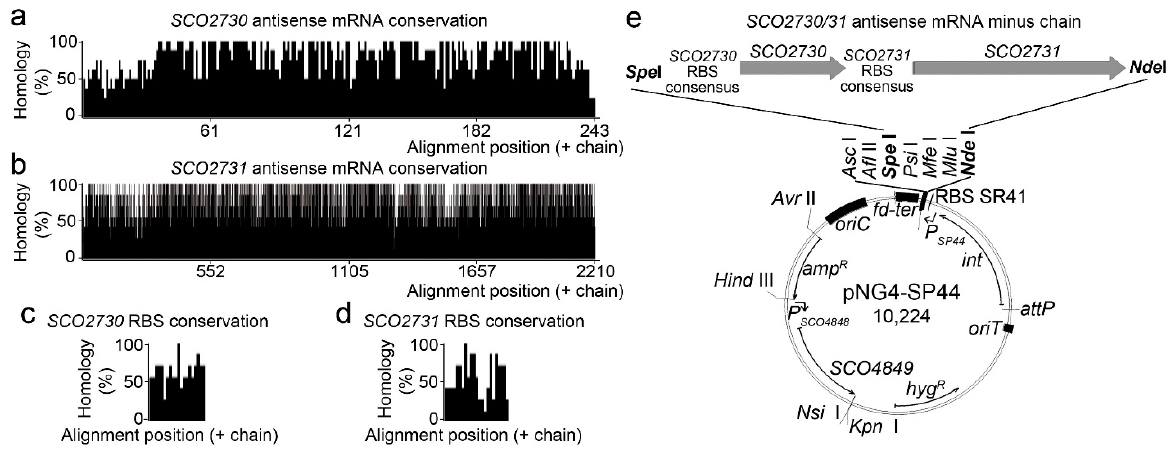
Figure 1. SCO2730/31 consensus antisense mRNA conservation and overexpression. ( a – d ) Histogram showing the percentages of homology of the SCO2730 and SCO2731 ORFs and the SCO2730 and SCO2731 RBSs. ( e ) Diagram showing the pNG4-SP44 overexpression plasmid controlling the expression of the SCO2730/31 antisense mRNA.